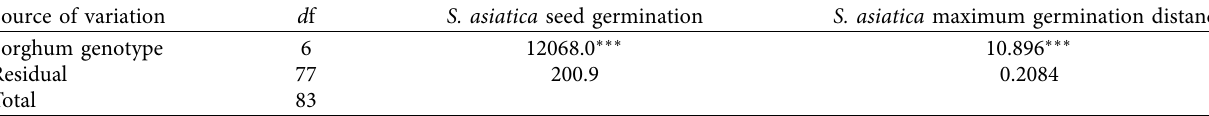
Table 3: Mean squares and significant tests on the S. asiatica seed germination maximum germination distance from the sorghum root. Source of variation